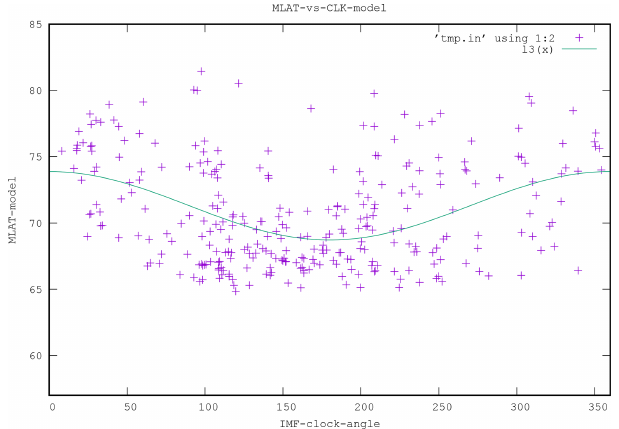
Figure 13. Average MLAT (over all events) as a function of MLT and CLK for the OpenGGCM